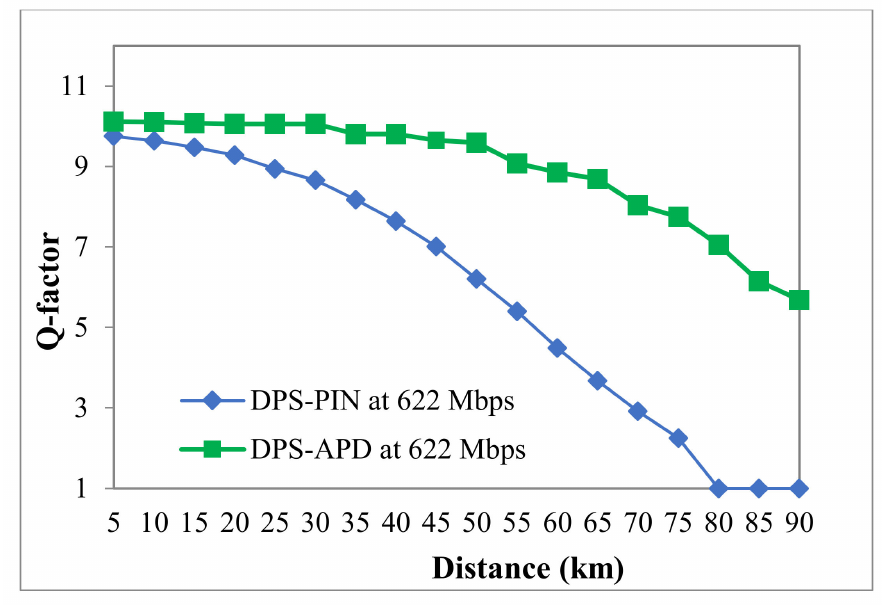
Figure 14. Q-factor versus fiber